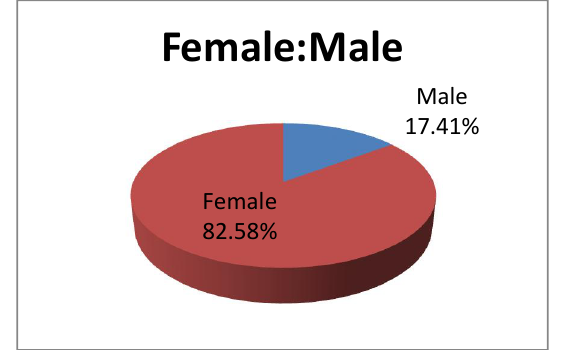
Figure 1: Female to Male